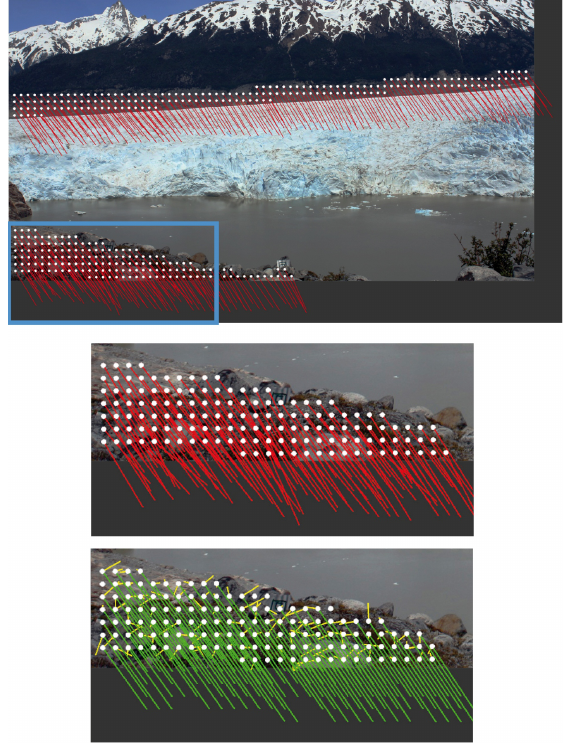
Figure 6. Modelling camera motion using natural static points. Measured camera motion (red vectors), modelled camera motion (green vectors), residuals (yellow vectors)